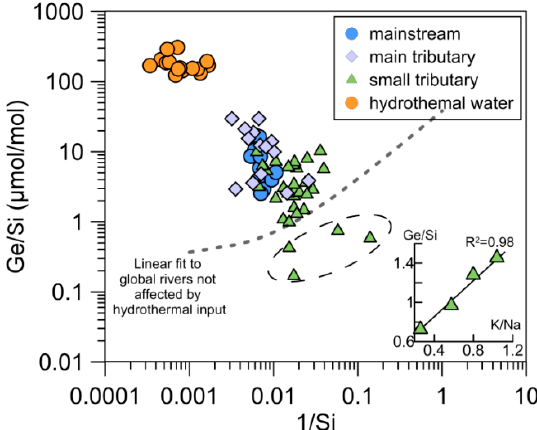
Figure 6. The relation between Si and Ge/Si in river water. The line for global clean rivers is from [17].